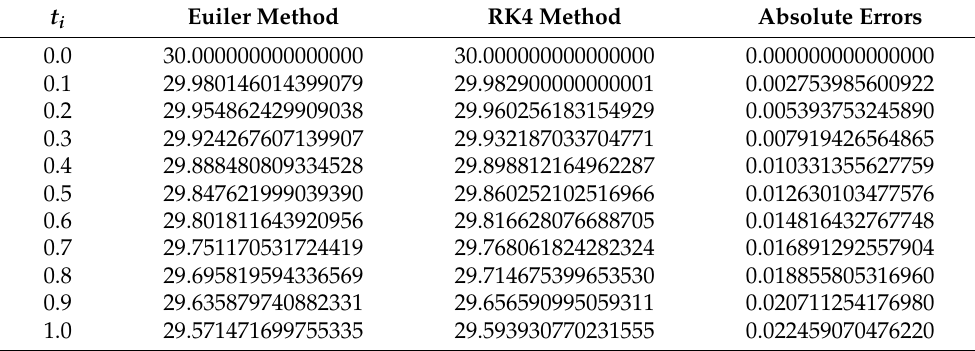
Table 4. Comparison between the results of the Euler method and RK4 method for I ( t ) .